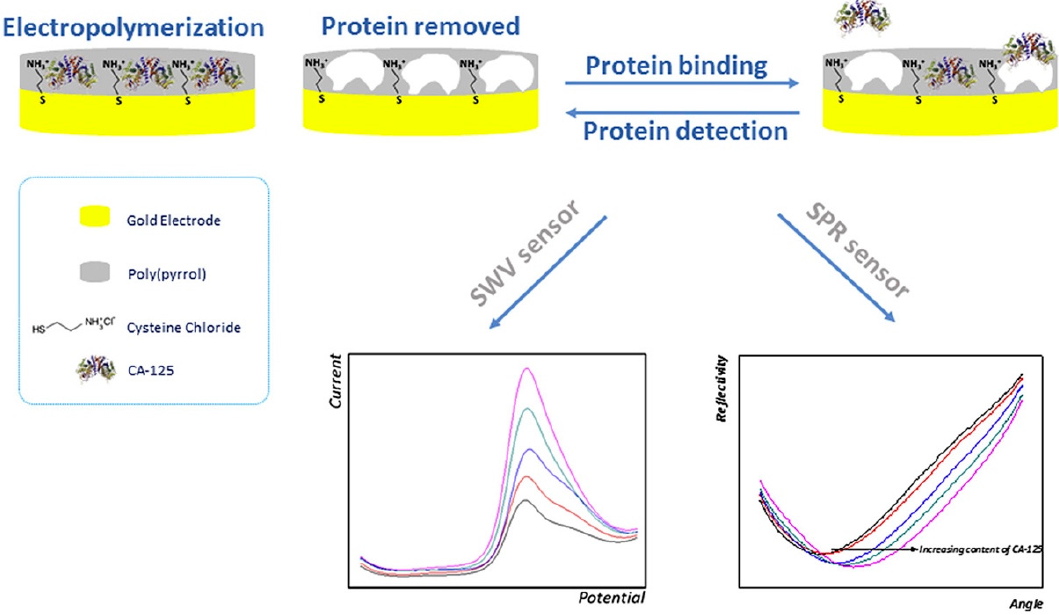
Figure 11. Schematic diagram of the MIP assembly for electrochemical and optical sensors. Reprinted from [90] with permission from Rebelo et al.